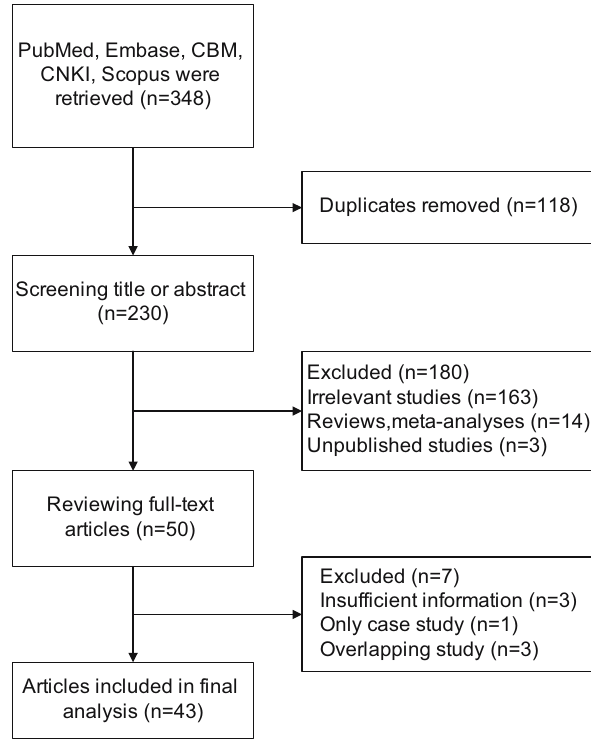
Figure 1: Study fl ow chart for the process of selecting the fi nal 43